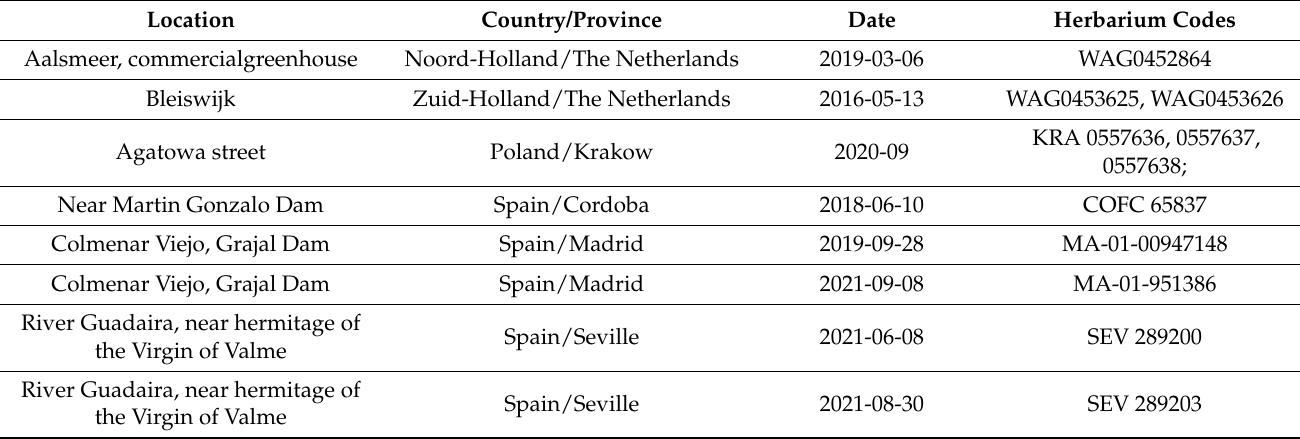
Table A2. Herbarium specimens of Hydrocharis laevigata relating to the European records.